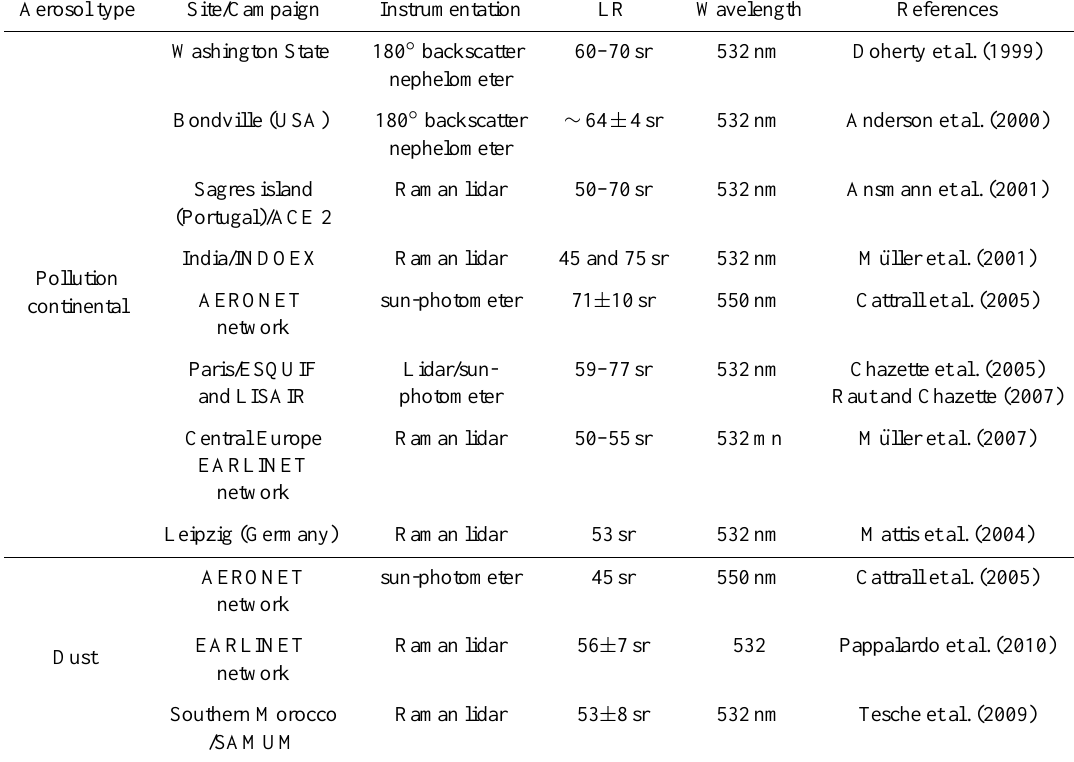
Table 3. LR found in the literature for pollution continental and dust